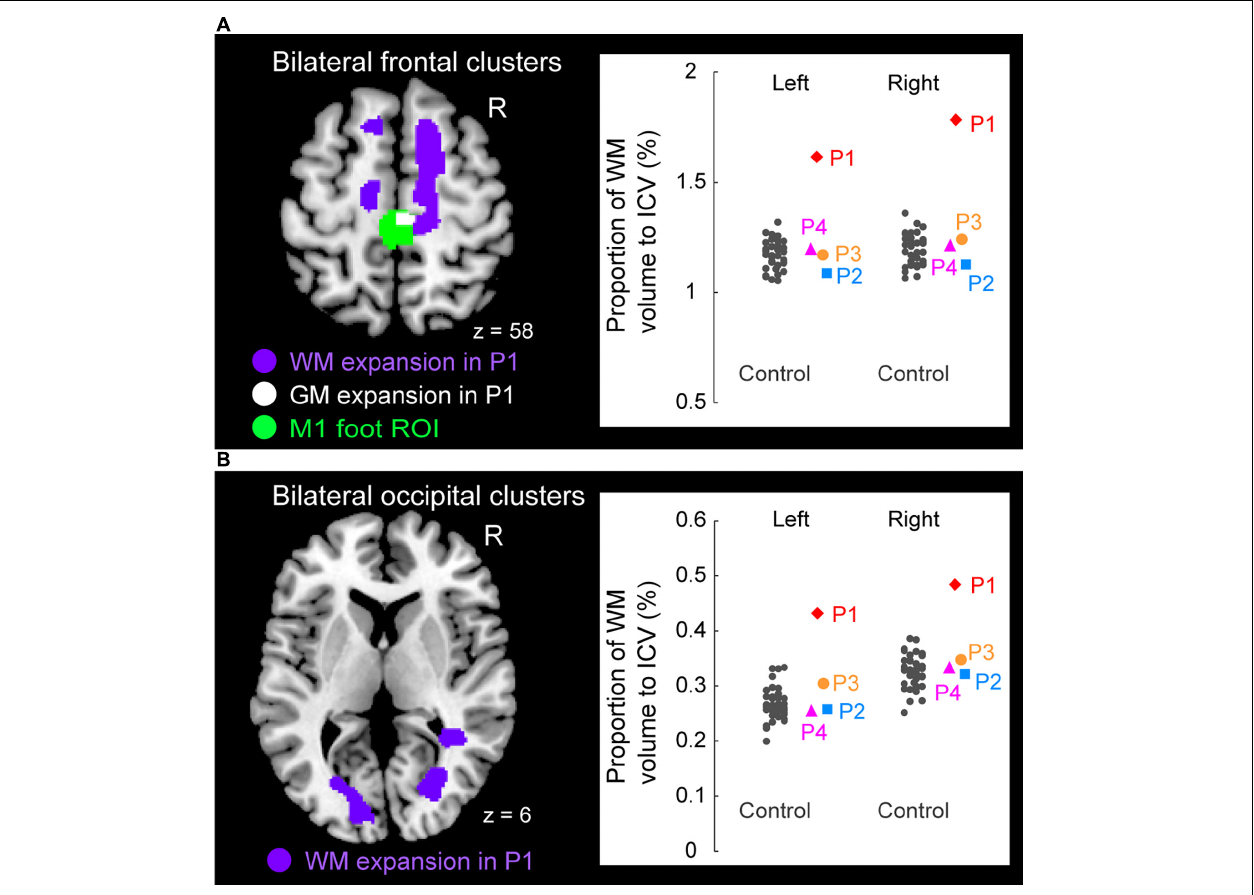
FIGURE 5 | Significant white matter (WM) expansion (purple sections) in participant P1 when compared with the control participants. Significant WM expansion was observed only in participant P1. The expansions were observed from the medial prefrontal cortices to the medial-wall motor regions (A) and in the structure along with the optic radiation (B) bilaterally. These sections are superimposed on the MNI standard brain. (A) The right medial frontal cluster seemed to connect to the right M1 foot section in which she showed GM expansion (white section) within the M1 foot ROI (green section). (A,B) The right panels in A and B show scatter plots of individual WM volumes obtained from the left and right medial frontal clusters (A) and from the left and right occipital clusters (B) , respectively. In each panel, a vertical axis represents the proportion of WM volume to ICV. A red diamond, blue rectangle, orange circle, and pink triangle represent the data obtained from paraplegic participants P1, P2, P3, and P4, respectively. Gray dots represent the data obtained from the control participants, and these are horizontally jittered to avoid over-plotting. GM, gray matter; WM, white matter; M1, primary motor cortex; ROI, region-of-interest; ICV, intracranial volume; MNI, Montreal Neurological